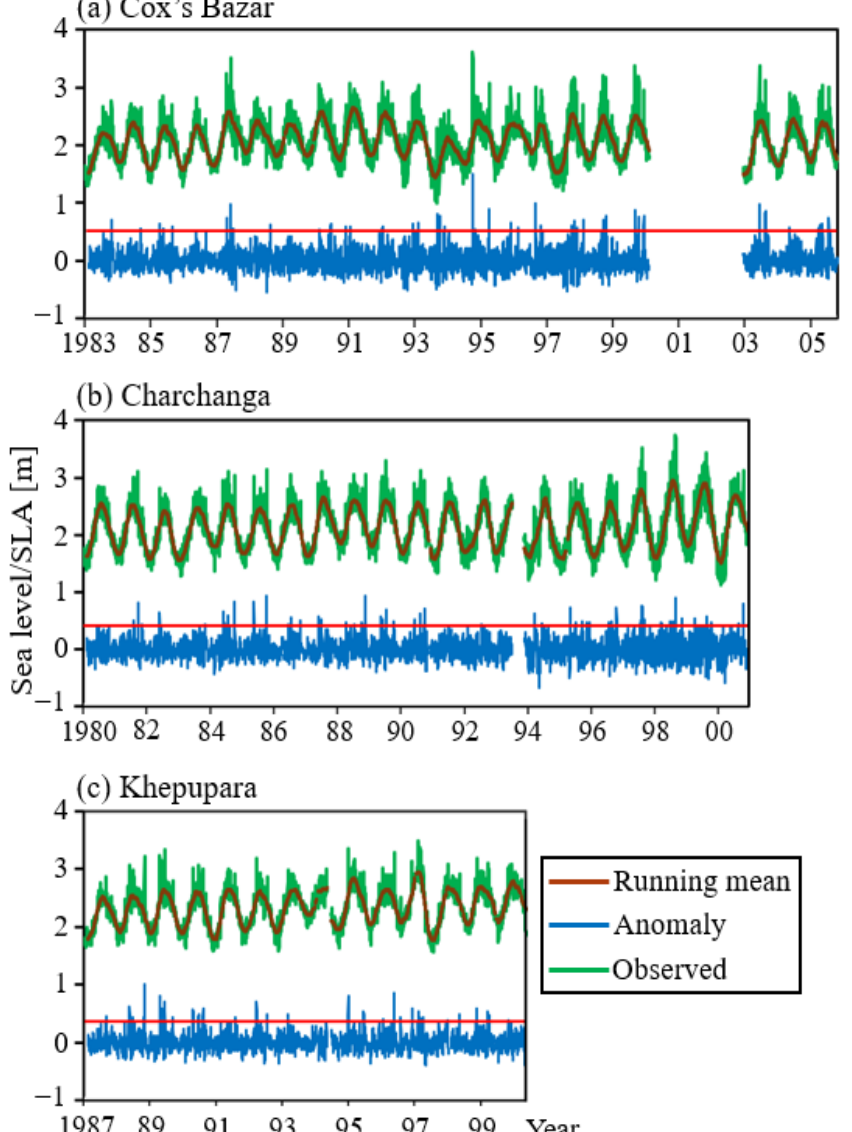
Figure 4. ( a ) Time series of daily sea levels at Cox’s Bazar during 1983–2006. The green line represents the observed daily sea level. The dark orange line shows the 91-day running mean, and the blue line shows SLA. The discontinuity in the time series denotes the missing data. ( b ) Same as ( a ) but for Charchanga during 1980–2000. ( c ) Same as ( a ) but for Khepupara during 1987–2000. The red lines in a, b, and c represent the 99th percentile values used for the selection of ESL events, which were 0.562 m, 0.486 m, and 0.427 m for Cox’s Bazar ( a ), Charchanga ( b ), and Khepupara ( c ), respectively.